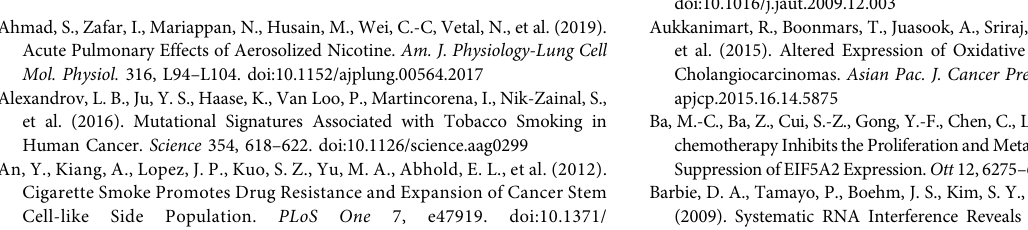
Supplementary Table 1 | Information about the included samples. Supplementary Table 2 | The results of GSEA between patients with any two smokinghistories( Sheet1 ).Identi fi cationandIntersectionofdifferentiallyexpressed genes between any two smoking histories in patients with various smoking histories (lncRNA & mRNA: Sheet 2 , miRNA: Sheet 3 , methylated genes: Sheet 4 ). Genes associated with OS were obtained through cox regression analysis ( Sheet 5 ). Risk scores for all samples were obtained via the prognostic model ( Sheet 6